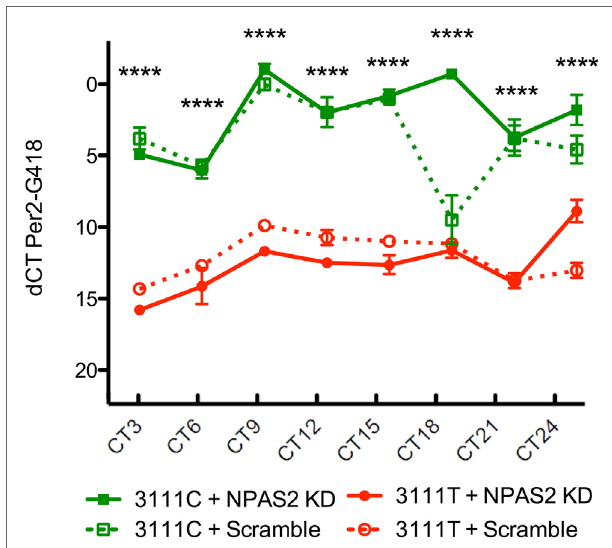
FigUre 4 | Twenty-four-hour expression of Per2 in 3111T/c snP-expressing MeFs . Clock 3111C gene expression over 24 h is significantly higher than Clock 3111T expression. **** P <